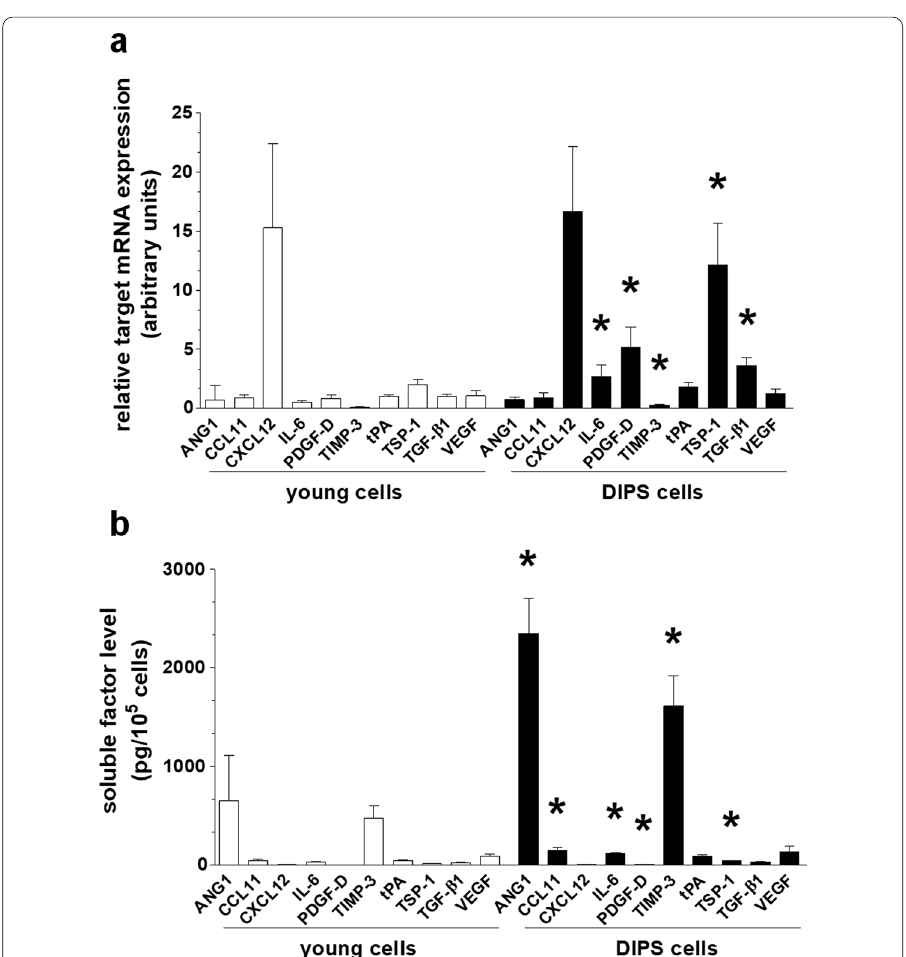
Fig. 6 Development of the senescence‑associated secretory phenotype (SASP) in DIPS cells. Changes in mRNA of arbitrarily selected targets, as quantified according to RT‑qPCR ( a ). Changes in the secretion of respective proteins into the environment (conditioned medium), as quantified by ELISA ( b ). The results are based on 6–8 independent experiments using HGSOCs obtained from different patients. The results are expressed as the means SEM. * p < 0.05 vs. young ±